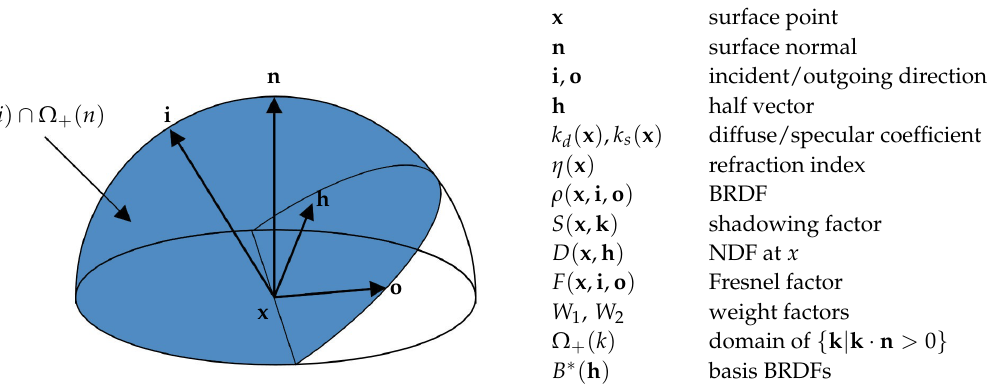
Figure 1. Integration domain of S ( x , i ) denoted as the blue area, and notations used in BRDF definition. Integration domain of S ( x , o ) can also be computed in the same